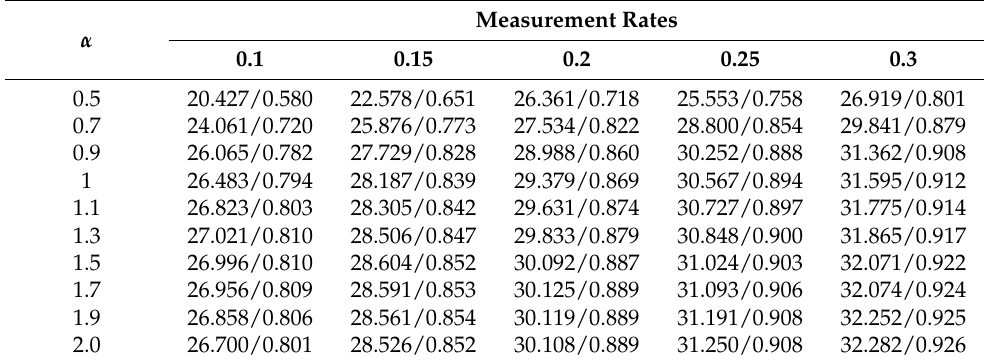
Table 2. PSNR (dB)/SSIM results for the different fractional-order for Lena